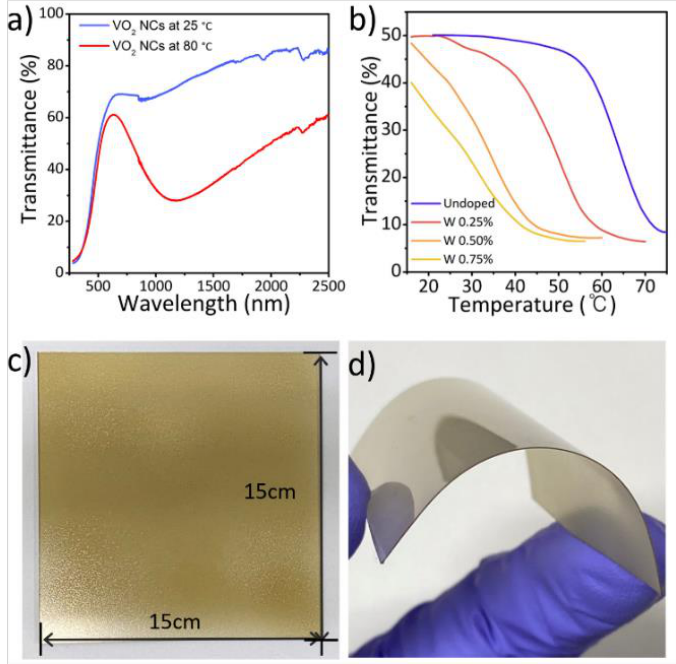
Figure 11. ( a ) Transmittance spectra of VO 2 (M) NP films before and after phase transition; ( b ) Temperature-dependent transmittance (1350 nm) of W-doped VO 2 (M) NP films during heating; Photographs of ( c ) 15 cm × 15 cm VO 2 (M) NP films on glass substrate and ( d ) flexible substrate obtained via spray-coating. Reproduced with permission from [136] . Copyright 2021, Elsevier.